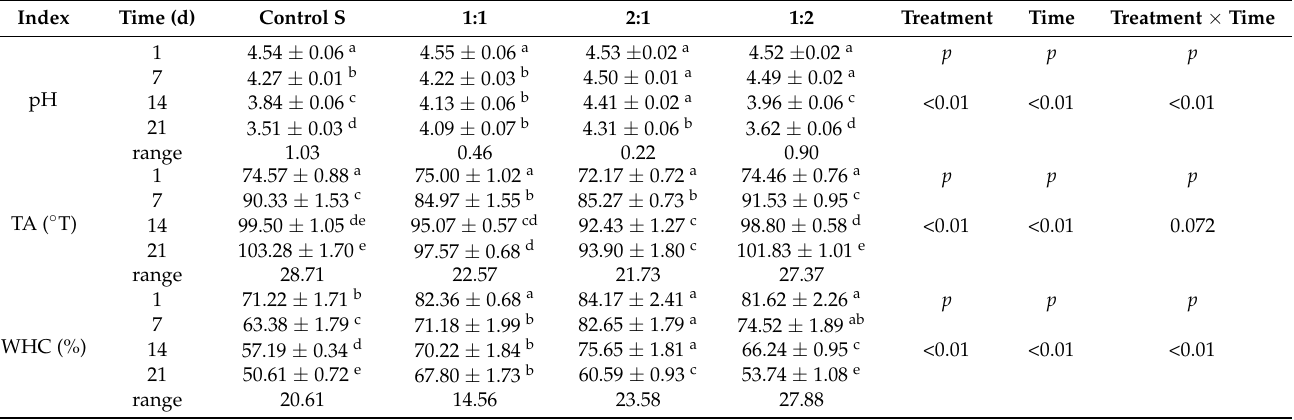
Table 5. Analysis of pH, TA, and WHC of four yogurt samples during storage. Data represented as the model-fitted mean ± standard errors. “a, b, c, d, e” indicate significant differences within yogurt groups during storage at p <